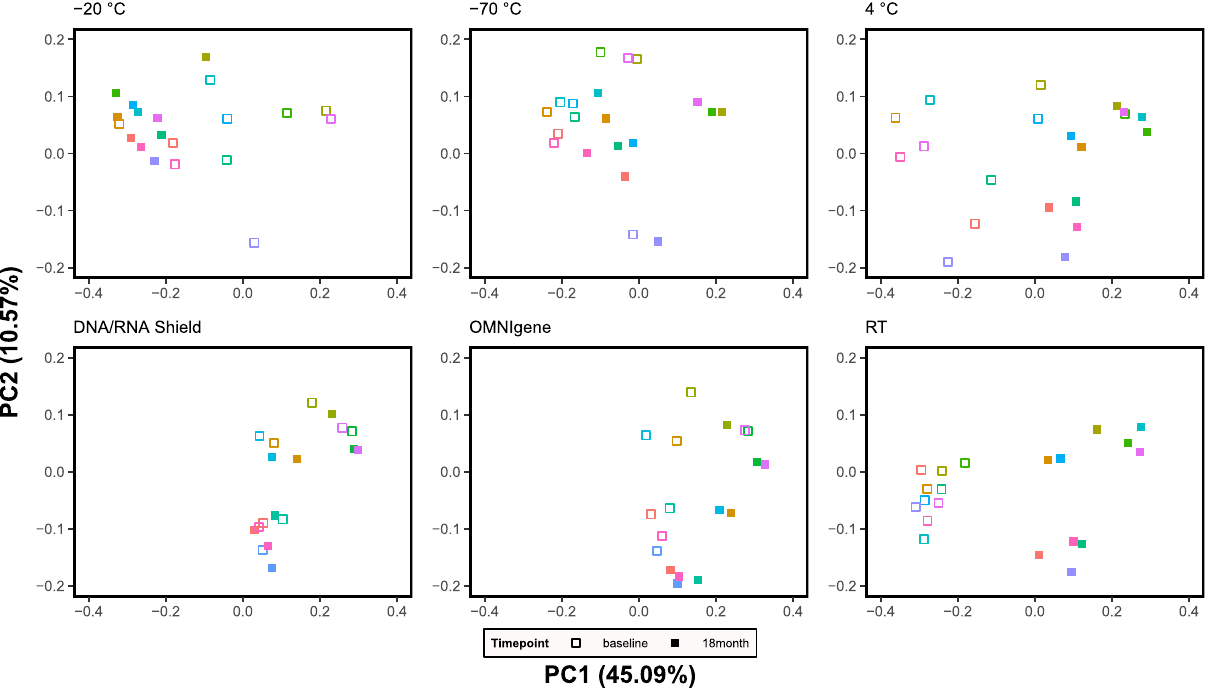
Figure 3. Principal coordinates analysis (PCoA) plot. Colors denote ten different subjects. DNA/RNA Shield DNA/RNA shield-fecal collection tube, OMNIgene OMNIgene-Gut, RT room temperature (20–25